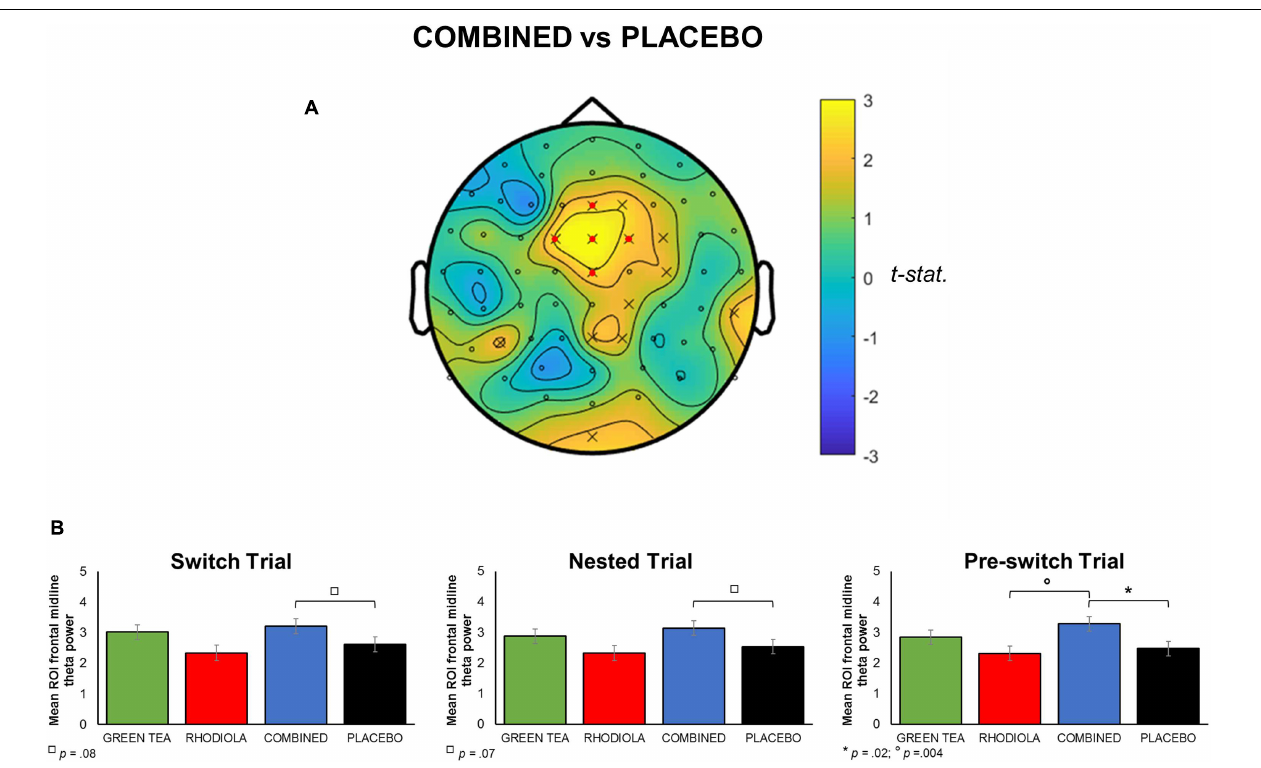
FIGURE 4 | (A) Map of t-statistic comparison of oscillatory theta band activity during attention switching task in COMBINED vs. PLACEBO treatments (positive values indicate COMBINED > PLACEBO in comparison). A priori defined ROI midline frontal electrodes shown in map by • . (B) Mean averaged ROI (SEM) frontal midline theta for each attention switching trial by